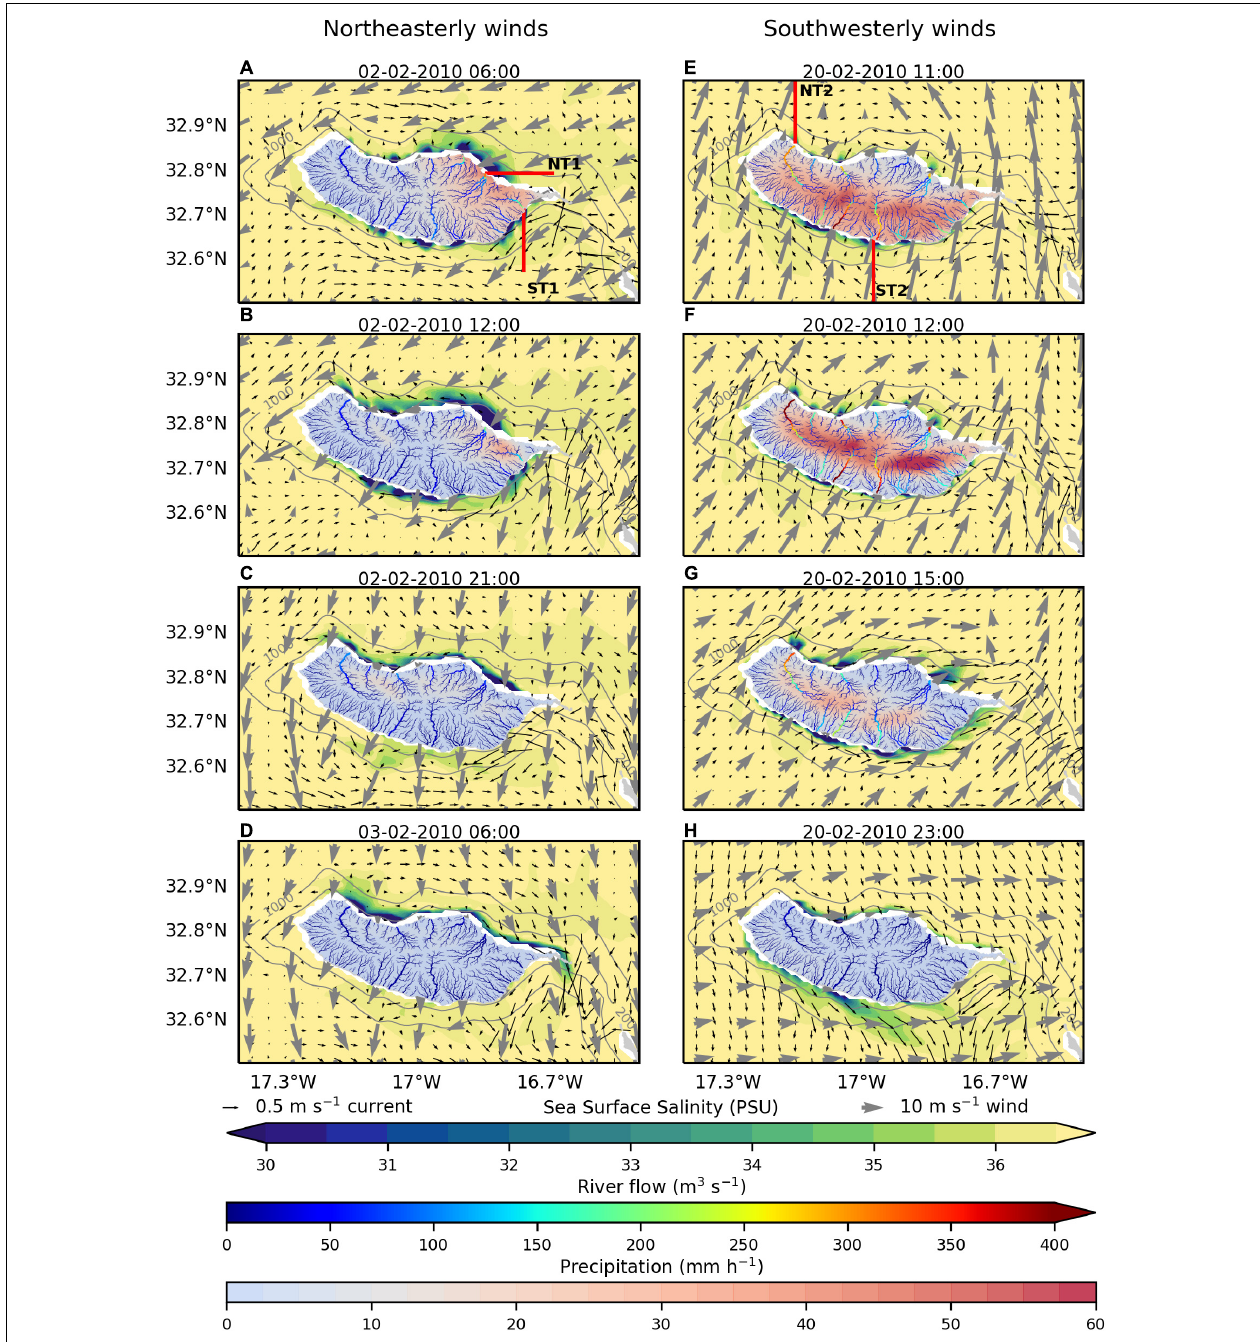
FIGURE 8 | Snapshots of the spatial variability of Sea Surface Salinity (PSU) along with surface currents (black arrows), wind (gray arrows), precipitation (mm h − 1 ), and river flow (m 3 s − 1 ) when (A–D) northeasterly (left panel) and (E–H) southwesterly (right panel) winds prevailed. See also Supplementary Video 1 . The gray lines represent the bathymetric lines 200 and 1000 m. The red lines indicate the location of the vertical transects shown in Figure 10